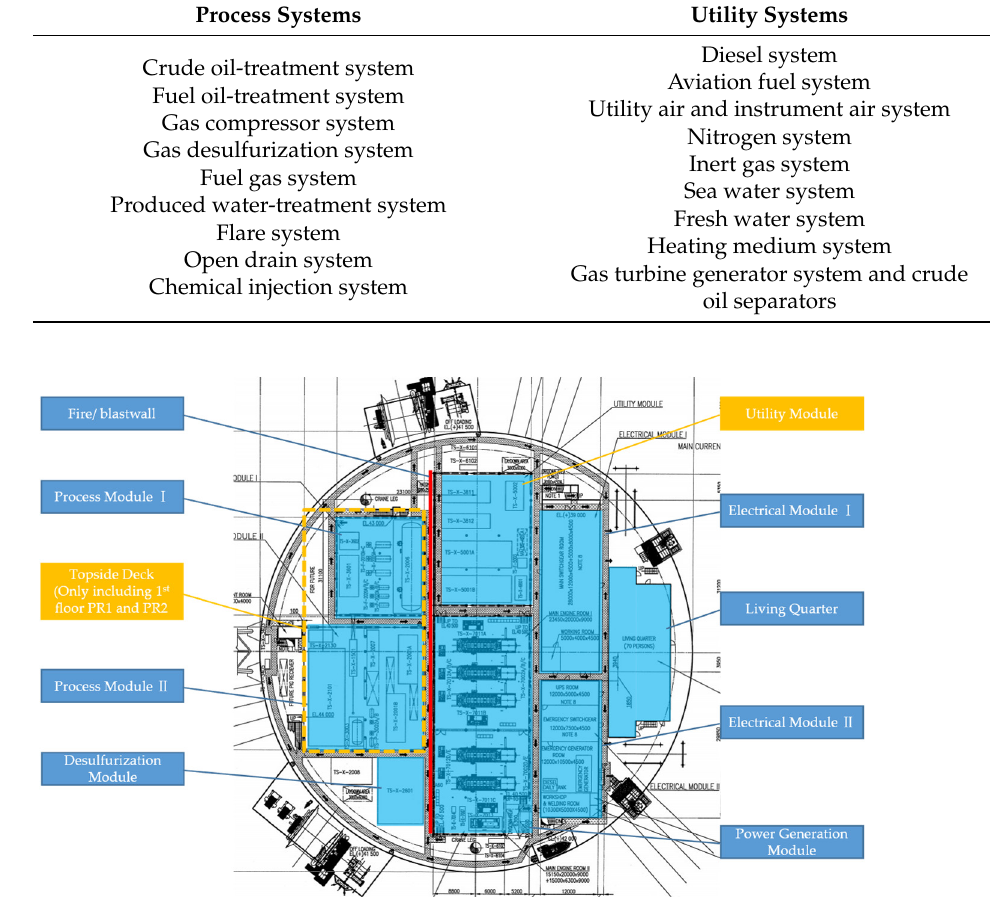
Figure 1. General layout of LH11-1 FPSO (topside view).